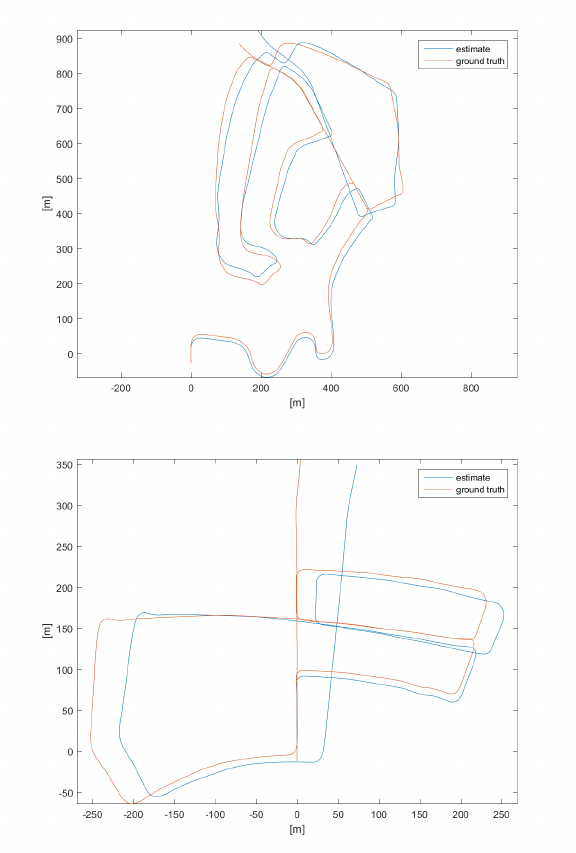
Figure 3. Tracking result for sequences 02 (upper plot) and 05 (lower plot) of the KITTI odometry challange.